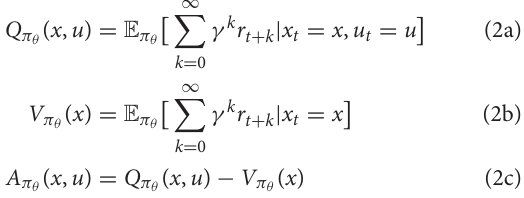
FIGURE 3 | The agent-environment interaction in a Markov Decision